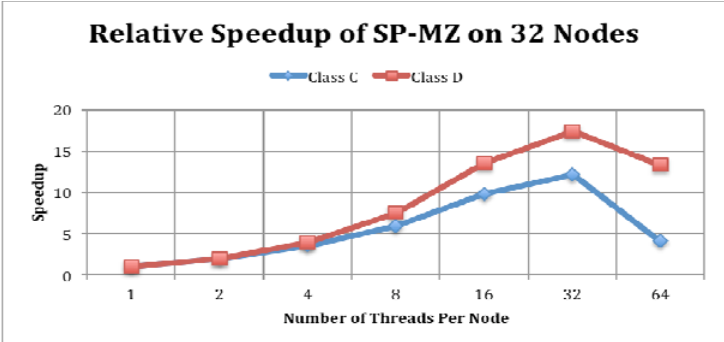
Figure 4. Performance comparison of SP-MZ on 32 Nodes with different number of threads per node